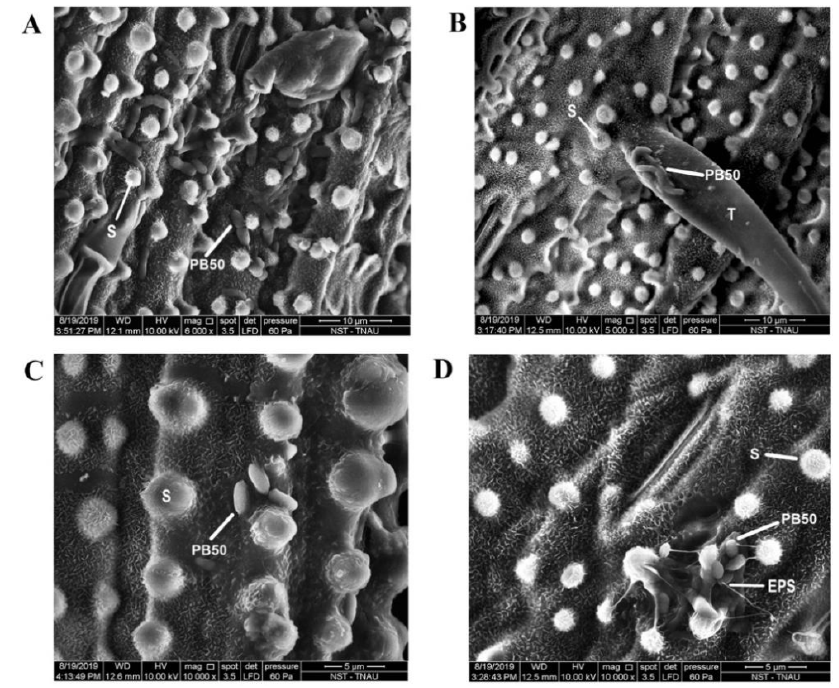
Figure 8. SEM images of Bacillus megaterium PB50 cells on the leaf surface of rice plants (T 4 ). PB50 strain colonization in the ridges of rice leaf surface ( A ), on trichomes ( B ), near silica bodies ( C ), and near stomata produced with exopolysaccharides (EPS) ( D ). S, silica body; T, trichome; and EPS,